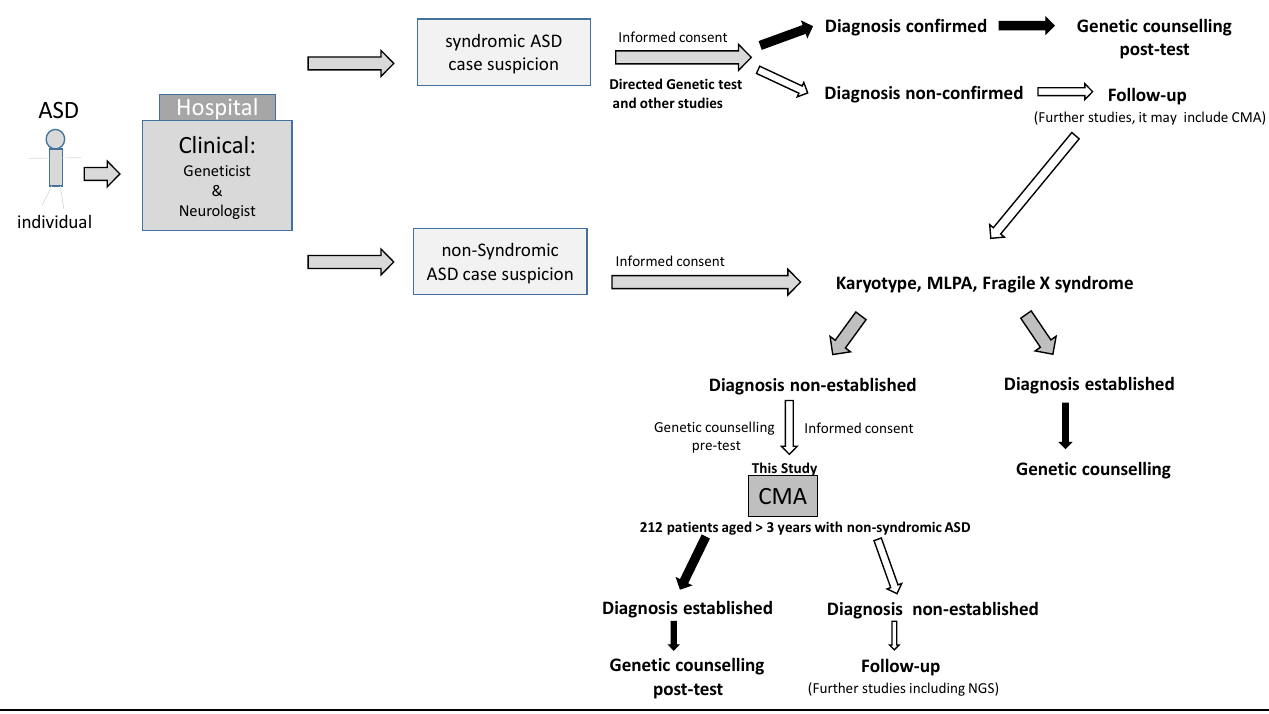
Figure 1. Algorithm used in patient selection. ASD—Autistic Spectrum Disorder); CMA—Chromosomal Microarray Analysis).